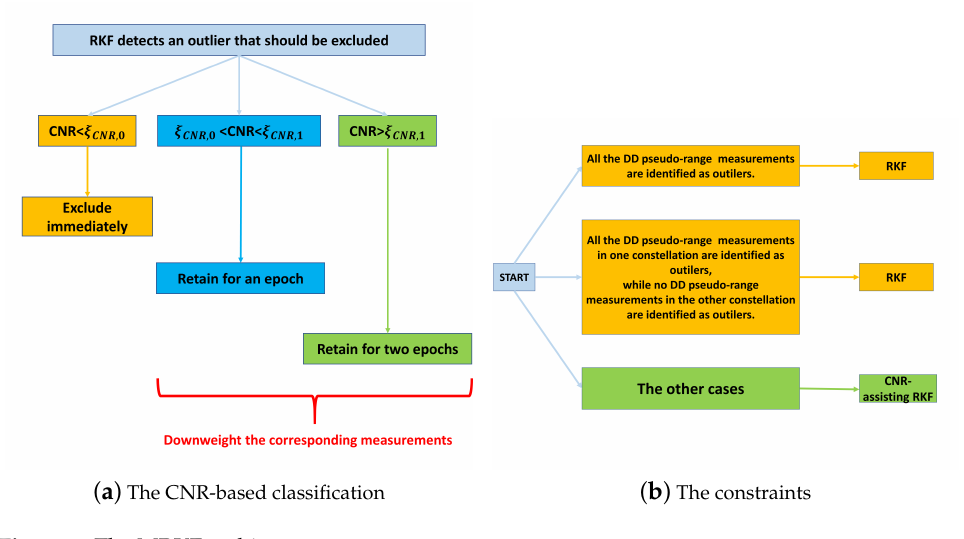
Figure 3. The MRKF architecture.